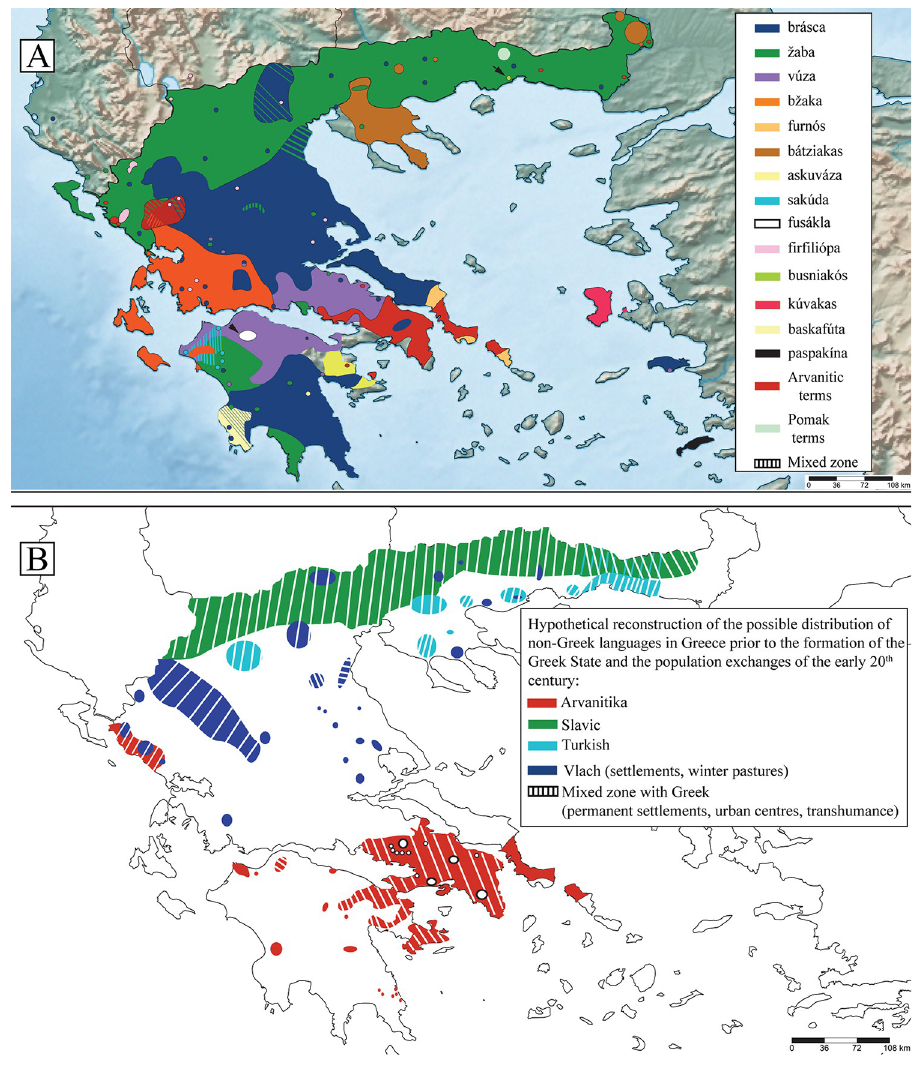
Fig 8. ( Α ) The current distribution of toad zoonyms, in relation to (B) the distribution of the main non-Greek languages of Greece in the early years of the 20 th century, according to [41, 79–81], and the maps according to [82, 83]. Coloured areas indicate only the dominant (but not unique) language of the rural population within their boundaries, and not the inhabitants’ ethnic identity or religion. Also, in the 20 th century, most of these areas were bilingual. The coloured areas include zones of movement of transhumant pastoralists, and do not necessarily indicate permanent settlement, nor do they indicate population density, which was higher in the (mainly) Greek-speaking towns. For Vlachs in particular, many of the coloured areas (e.g. in Thessaly) functioned only as winter pastures. It should be emphasised that the map depicted here is only indicative of the situation in the beginning of the 20 th century and not of the present one, as the linguistic and demographic composition of the region changed radically with the Balkan Wars and the population exchanges determined by the Treaties of 1913, 1914, 1919 (Neuilly) and 1923 (Lausanne) [84–87]. It should also be noted that the dense Greek-speaking populations of eastern Thrace, western-northeastern Asia Minor, and southern Albania are not depicted, as this map only concerns the linguistic situation within the borders of the modern Greek